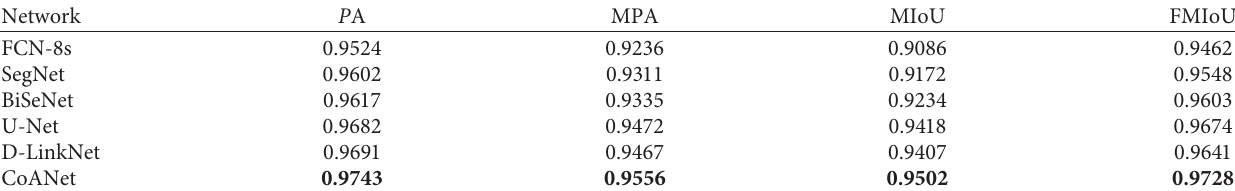
Figure 11: Variation curves of evaluation index for different networks. (a) MPA variation curves of different models. (b) MIoU variation curves of different models. Table 4: Comparison of evaluation indexes of different river segmentation